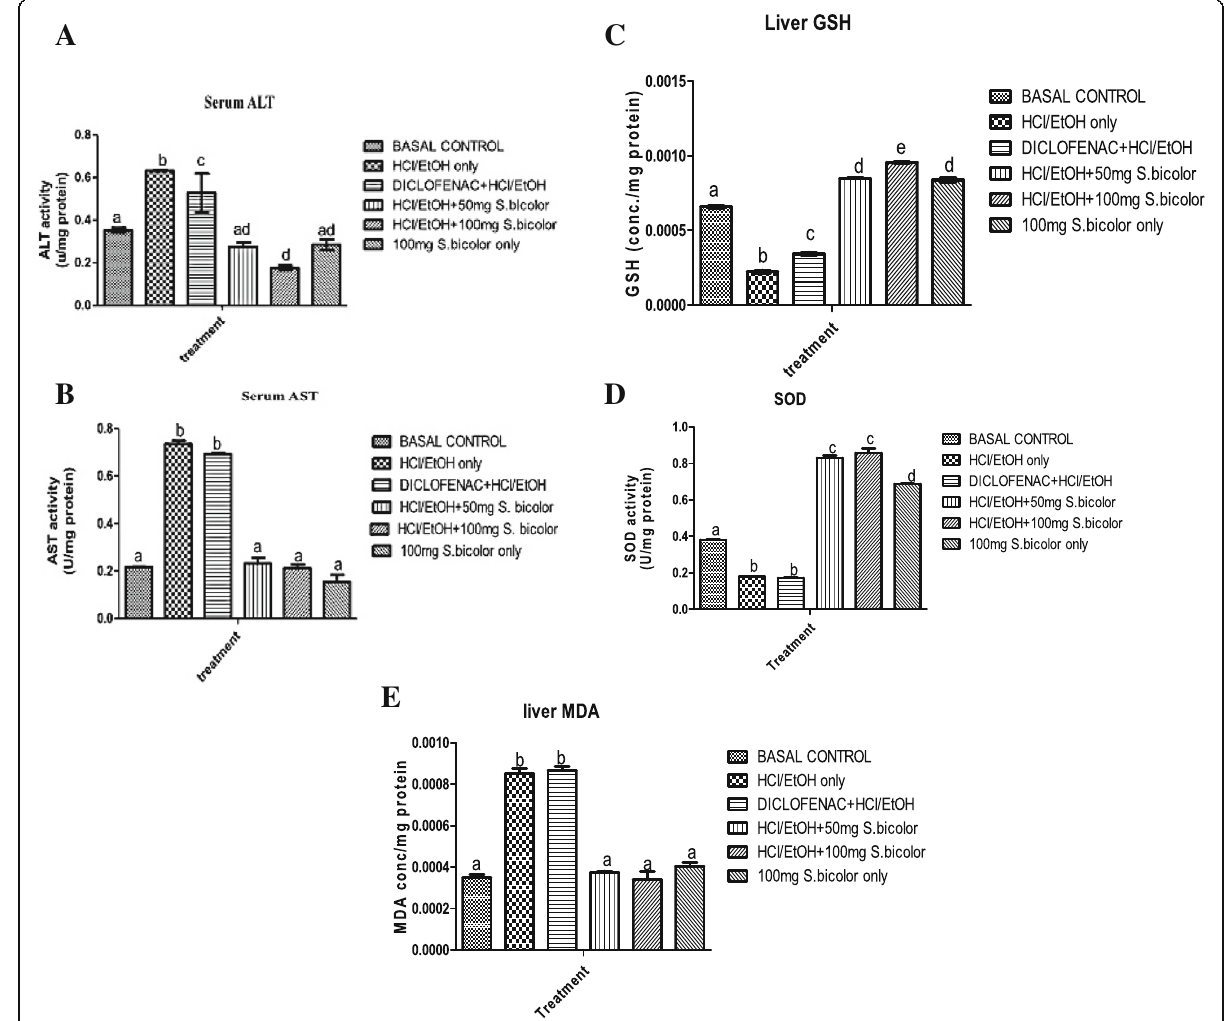
Fig. 5 a Effect of SBFE on HCl/ethanol-induced changes in serum alanine aminotransferase activity. Values are expressed as mean ± Standard error of mean ( n = 6/group). P < 0.05 is considered to be statistically significant. Bars with different alphabets are statistically significant. b Effect of SBFE on HCl/ethanol-induced changes in serum aspartate transaminase activity. Values are expressed as mean ± Standard error of mean ( n = 6/group). P < 0.05 is considered to be statistically significant. Bars with different alphabets are statistically significant. c Effect of SBFE on HCl/ ethanol-induced changes in hepatic reduced glutathione levels. Values are expressed as mean ± Standard error of mean ( n = 6/group). P < 0.05 is considered to be statistically significant. Bars with different alphabets are statistically significant. d Effect of SBFE on HCl/ethanol-induced changes in hepatic superoxide dismutase activity. Values are expressed as mean ± Standard error of mean ( n = 6/group). P < 0.05 is considered to be statistically significant. Bars with different alphabets are statistically significant. e Effect of SBFE on HCl/ethanol-induced changes in hepatic malondialdehyde (MDA). Values are expressed as mean ± Standard error of mean ( n = 6/group). P < 0.05 is considered to be statistically significant. Bars with different alphabets are statistically